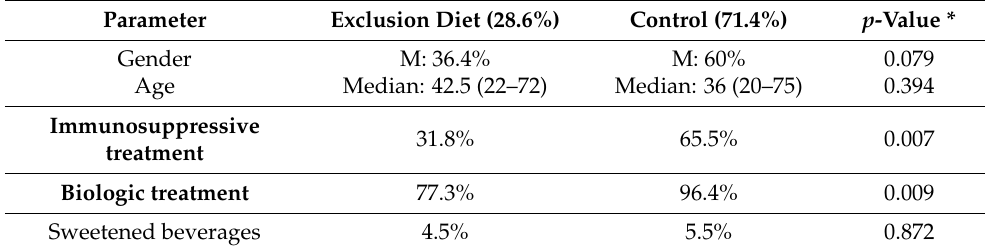
Table 4. Baseline characteristics for the CD